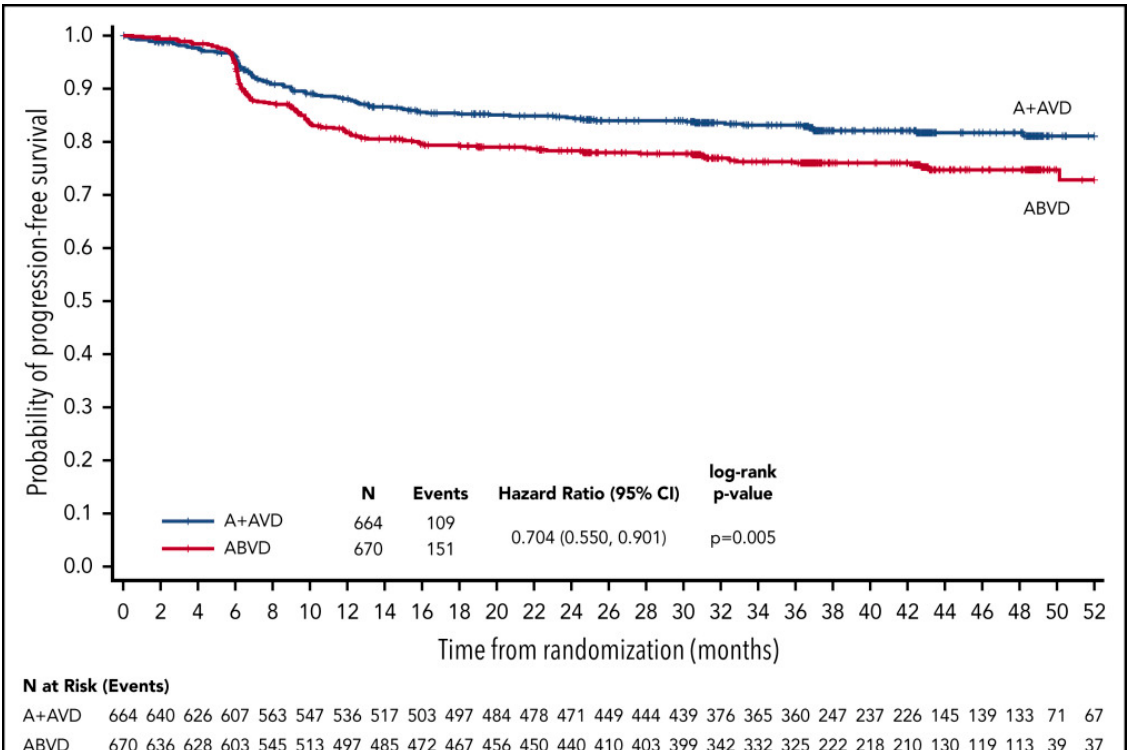
Figure 2. Kaplan–Meier curves of PFS for intent-to-treat patients receiving A + AVD or ABVD in the ECHELON-1 Study. Hazard ratio is for 3-year PFS comparison between groups (reproduced with permission after [31]). A + AVD = brentuximab vedotin plus doxorubicin, vinblastine, and dacarbazine; ABVD = doxorubicin, bleomycin, vinblastine, and dacarbazine; CI = confidence interval; PFS = progression-free survival.